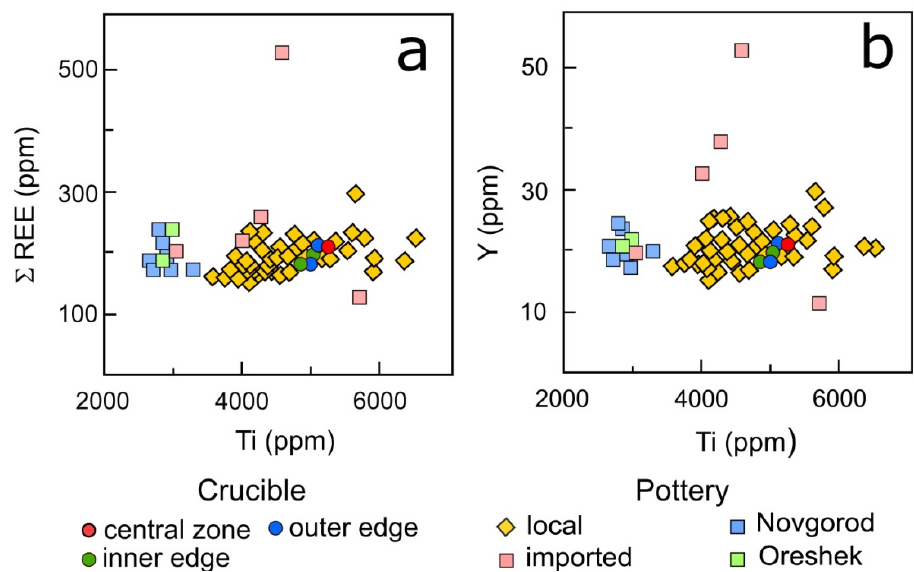
Figure 9. Ti- Σ REE ( a ) and Ti-Y ( b ) bivariate diagrams illustrating the fabric composition of the crucible compared with various ceramic groups: local pottery of Karelian hillforts, imported pots, and ceramics from Novgorod and Oreshek.